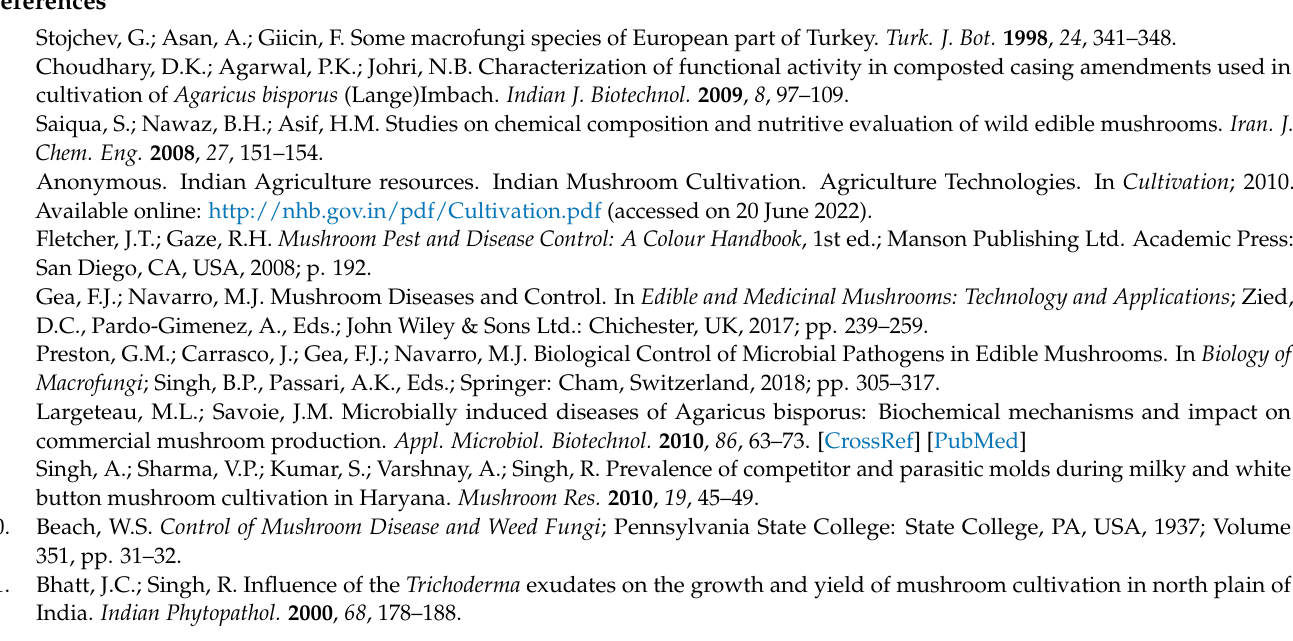
Figure S3. Evaluation of bioassay of bacterial antagonists and botanicals against the green mold disease of white button mushroom, Figure S4: In vitro evaluation of bacterial antagonists against the green mold pathogen ( T. harzianum ) and white button mushroom ( A. bisporus ), Table S1: Mean sum of squares of botanical extracts, TableS2: Mean sum of squares of bacterial antagonists, Table S3. In vivo effect of botanical extracts on quality parameters of white button mushroom ( Agaricus bisporus ) and Table S4. In vivo effect of bacterial antagonists on quality parameters of white button mushroom ( Agaricus bisporus